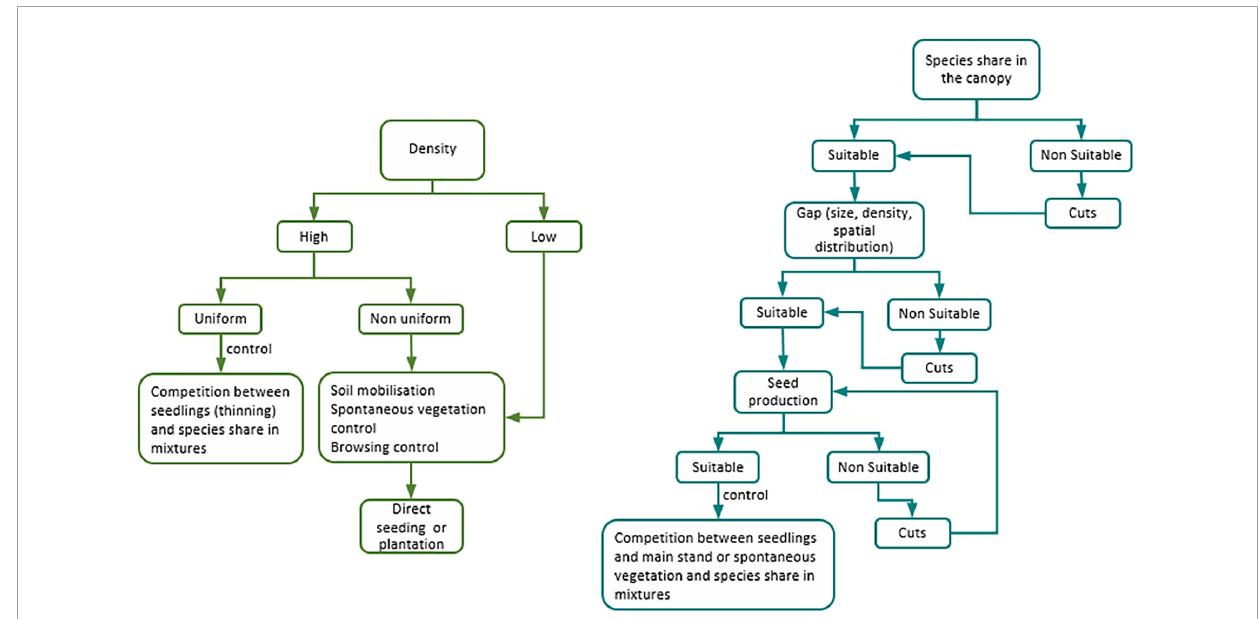
FIGURE2 Factors influencing natural regeneration in clear-cut/uniform shelterwood (left) and irregular shelterwood and selection (right) systems.